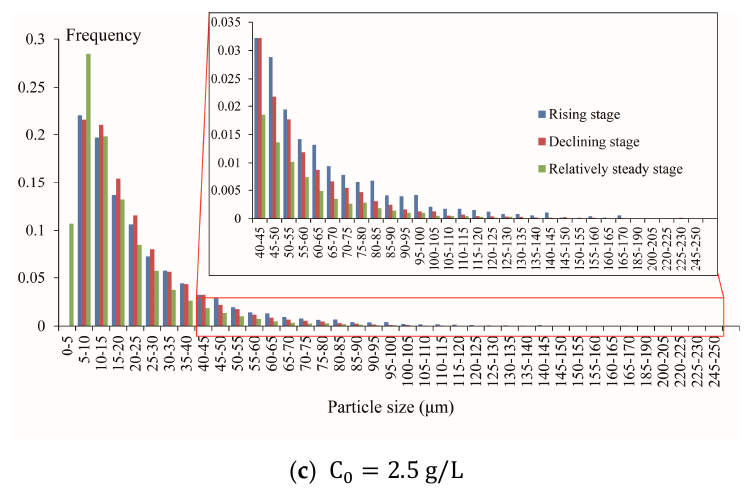
Figure 7. Iron aggregate size in effluents for different injected concentrations: ( a ) C 0 = 0.5 g/L; ( b ) C 0 = 1.5 g/L; ( c ) C 0 = 2.5 g/L.